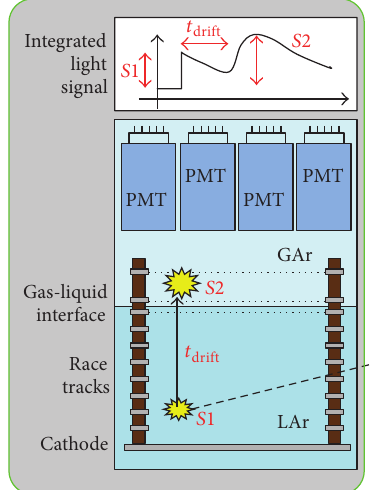
Figure 1: Working scheme of the inner